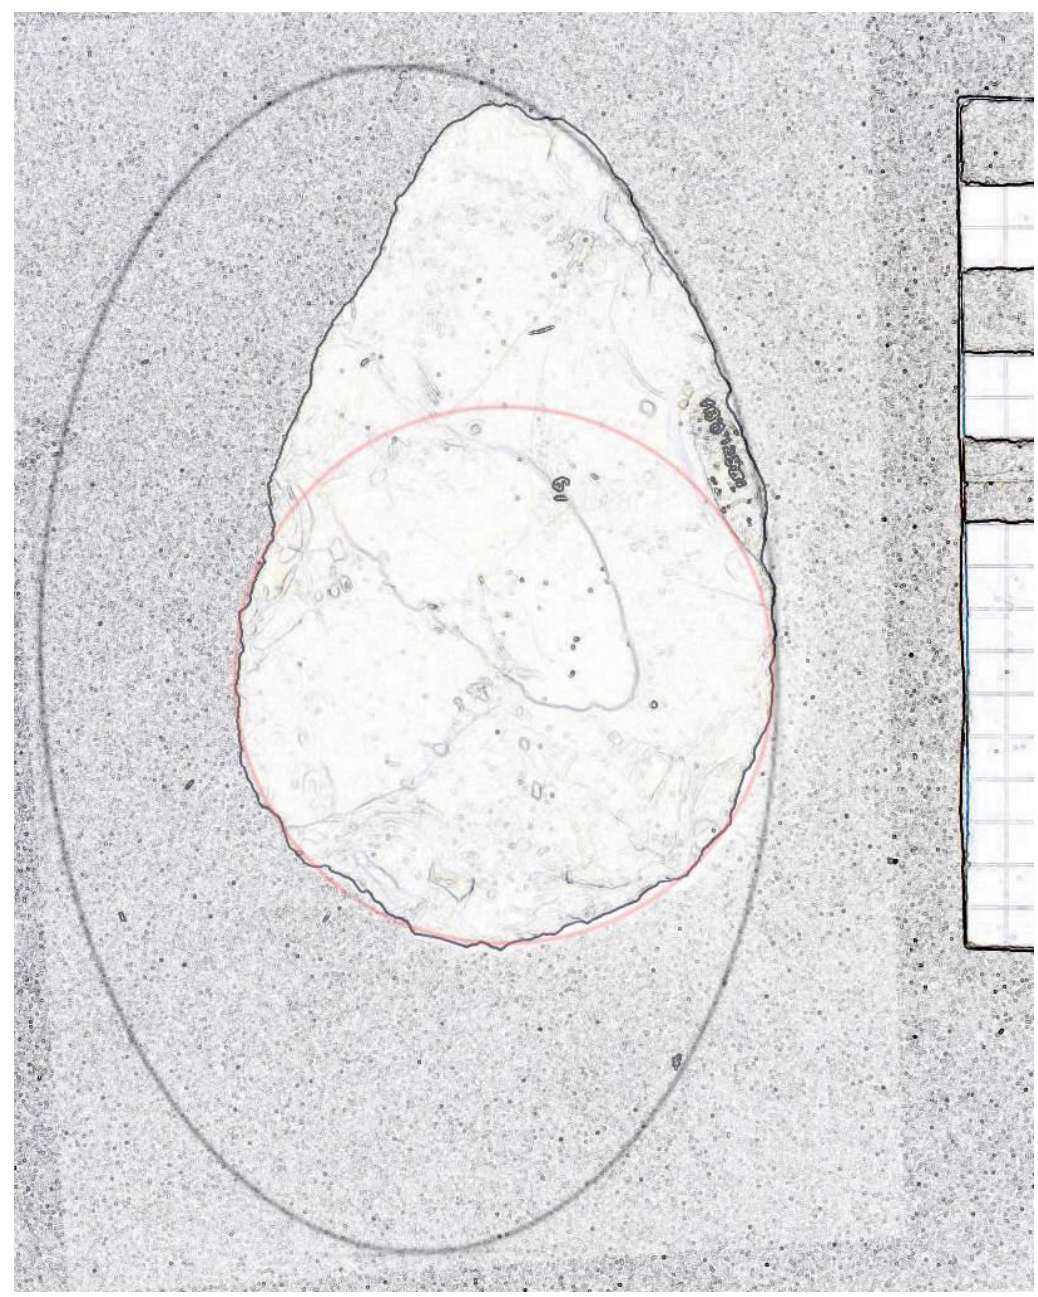
Figure 16. Specimen